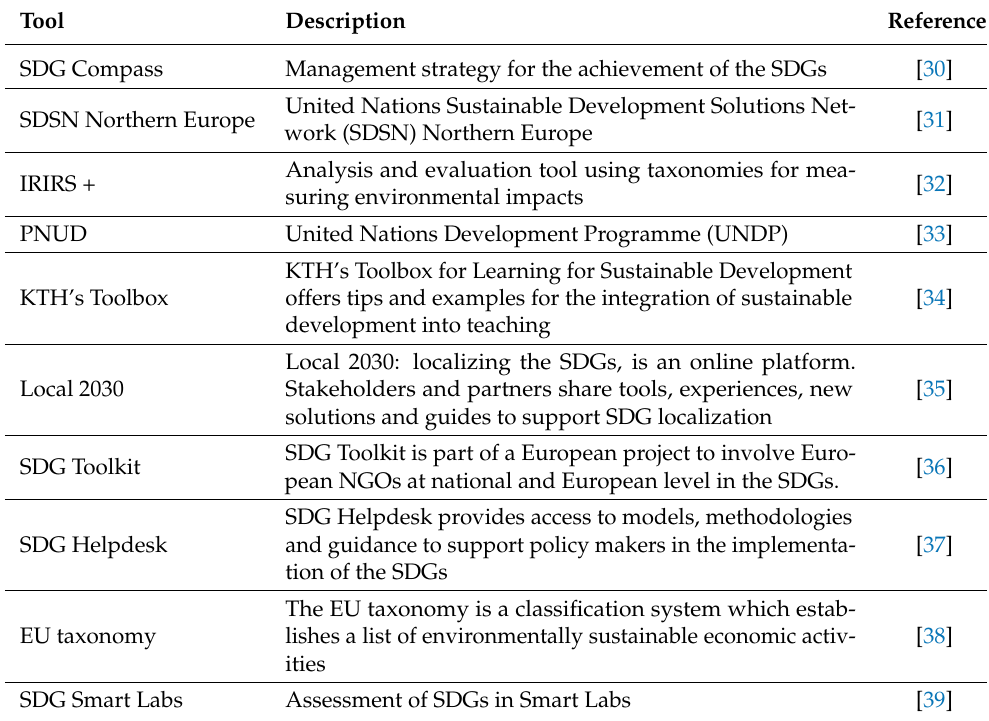
Table 1. SDG Assessment Tools.